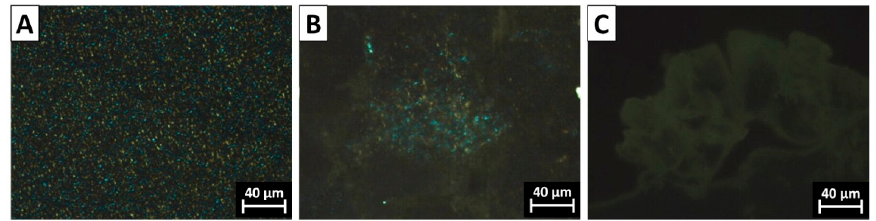
Figure 6. POM images of the PVDF@c–PMMA samples with the weight ratio of: ( A ) 77/23; ( B ) 60/40; and ( C ) 48/52.